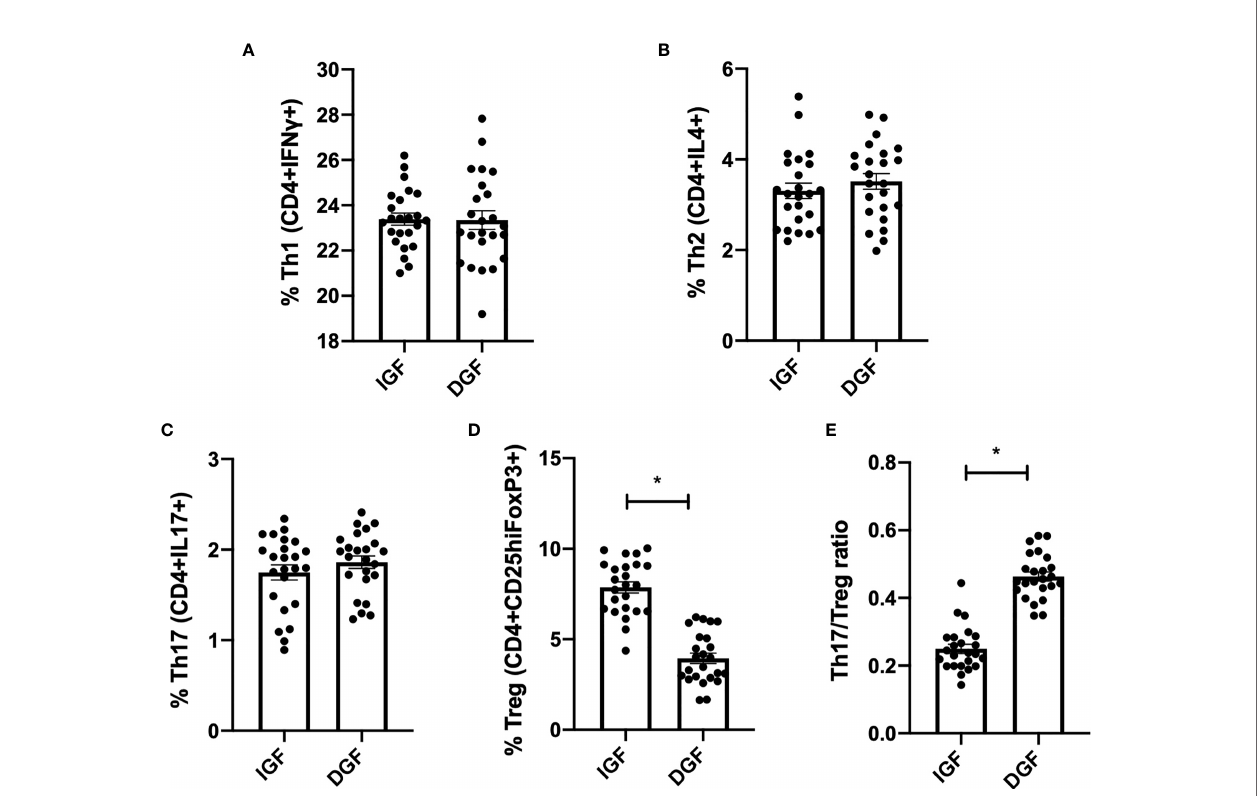
FIGURE 4 | KP-EV suppress the induction of Treg and increase Th17/Treg ratio, to a greater extent in patients with DGF. (A – E) For T cell assays, culture plates were coated with 1 m g/mL of anti-CD3 mAb (OKT3) and 2 m g/mL of anti-CD28 mAb; PBMC from HC (n=5) were seeded with KP-EV derived from recipients with IGF (n=6) or DGF (n=6). At day 7, cells were stained for CD4, CD25, IFN g , IL4, IL17 and FoxP3 and percentages of subpopulations of (A) Th1 (CD4+IFN g +), (B) Th2 (CD4+IL4+), (C) Th17 (CD4+IL17+), (D) Treg (CD4+CD25hiFoxP3+) and (E) the ratio of Th17 to Treg were measured by fl ow cytometry. Each data point represents a KP-EV (n=6 IGF, n=6 DGF) exposed to HC PBMC (n=4) (technical duplicates). *represents p-values ≤